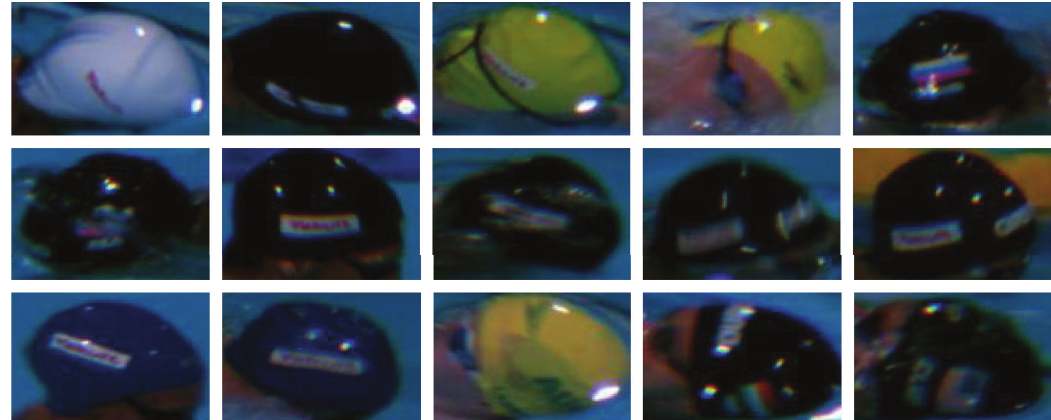
Figure 11: Examples of the training database. World Championships, Barcelona 2013 and Kazan